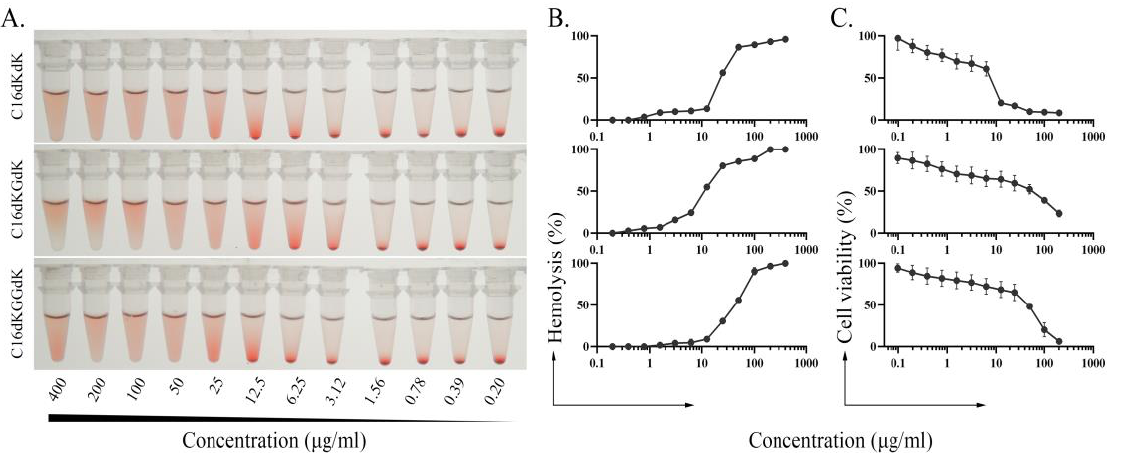
Figure 3. Hemolytic activity and Cytotoxicity of synthetic lipopeptides. ( A ) The gradient-diluted lipopeptides were added to a 2% mouse red blood cell PBS suspension and incubated for 1 h at 37 °C. ( B ) 100 μL of the hemolytic activity assay supernatant was pipetted, and the absorbance at OD540 was measured to plot the hemolytic activity function of the lipopeptide. The horizontal coordinate represents the lipopeptide concentration, and the vertical coordinate represents the erythrocyte hemolysis rate. ( C ) CCK8 was used to determine the cytotoxicity of lipopeptides. The horizontal coordinate represents the lipopeptide concentration, and the vertical coordinate represents the cell survival rate.